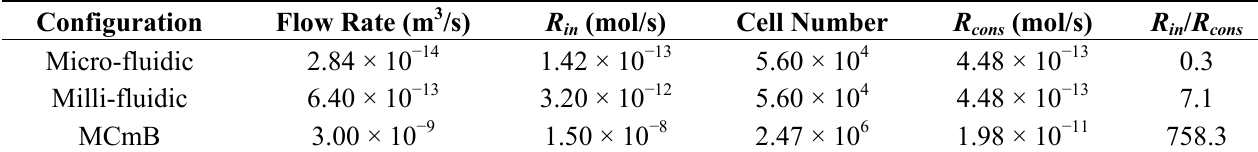
Table 6. Glucose supply and consumption for the three configurations